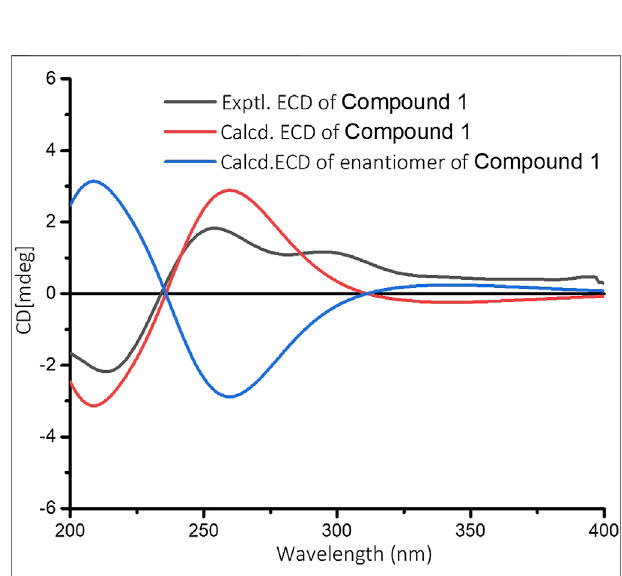
FIGURE 5 | Experimental ECD spectrum of 1 and calculated ECD spectra for (3 R , 4 R )- 1 and its enantiomer in MeOH.